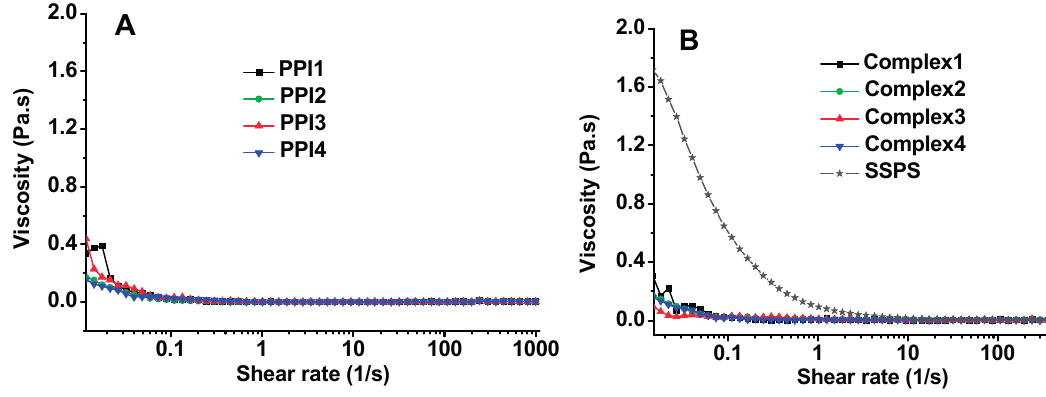
Figure 5. Viscosities of ( A ) PPI, and ( B ) SSPS and PPI/SSPS complex solutions as a function of shear